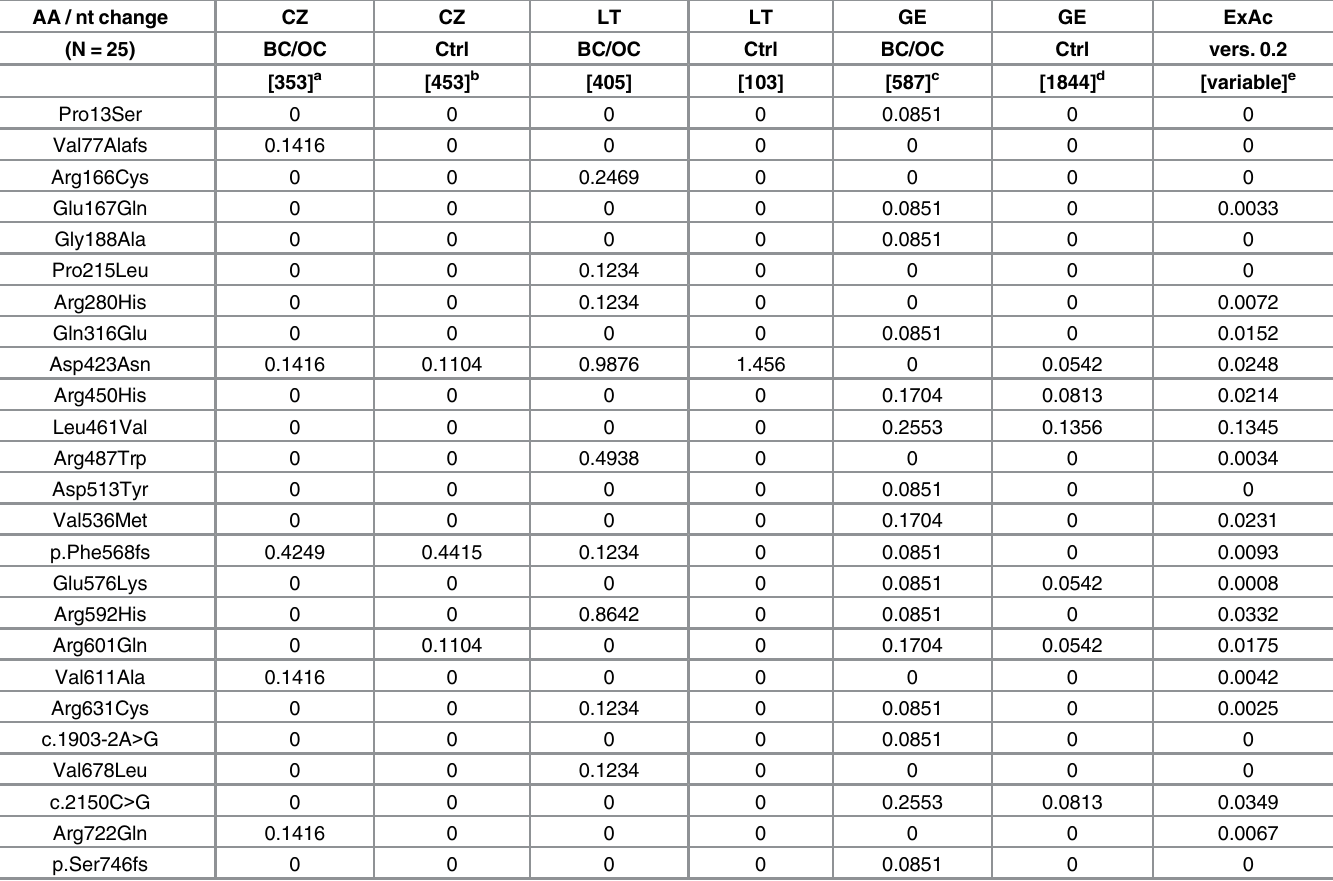
Table 2. ERCC2 allele frequencies (%) in BC/OC patients and corresponding control cohorts. The allele frequency is counted on the basis of sample size (in brackets) and number of observed cases (see Table 1) with hetero- and